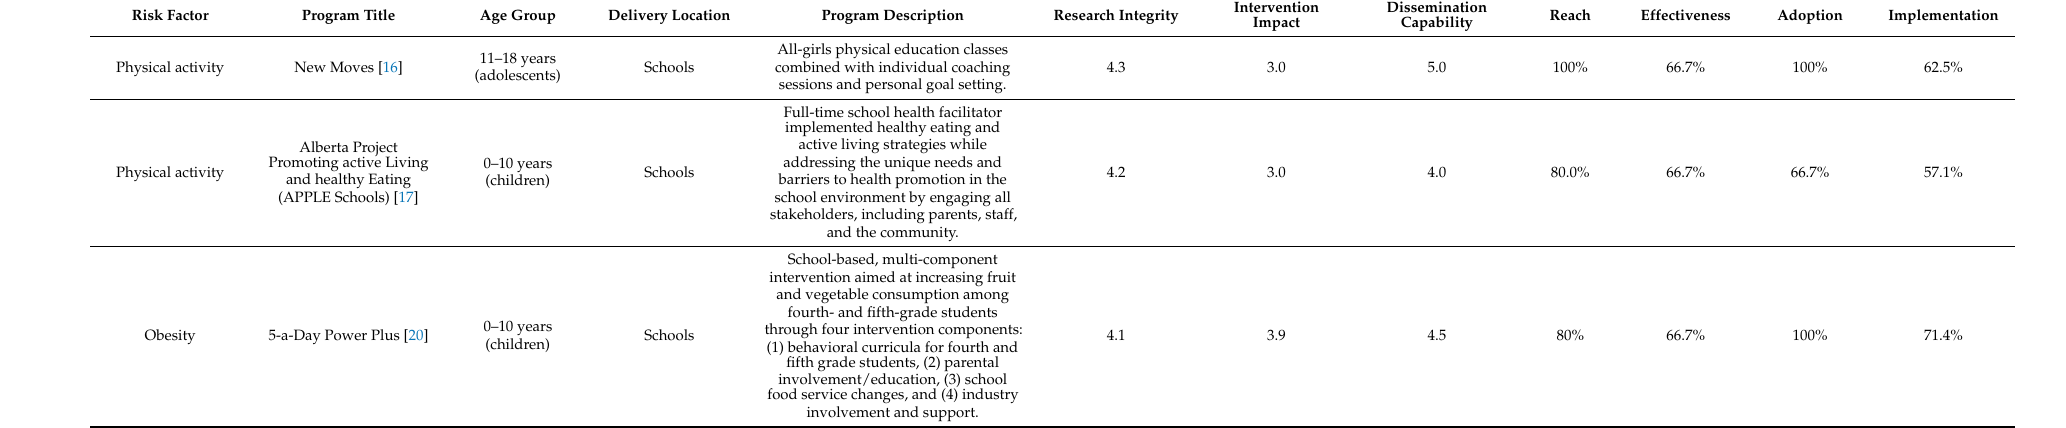
Table 2. Summary of high-quality, multilevel NCI EBCCPs developed and evaluated in populations facing breast cancer